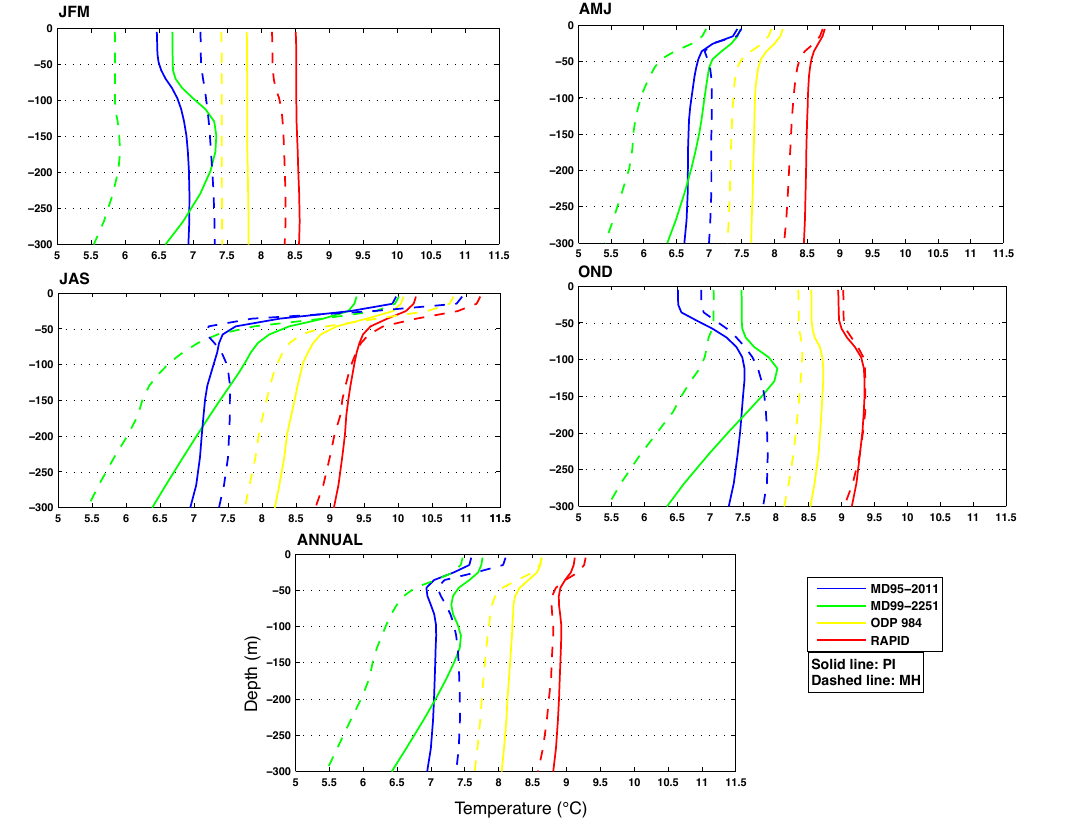
Fig. 12. Average annual and seasonal temperature profiles 0–300m depth for site MD95-2011, MD99-2251, ODP 984, and RAPiD-12-1K from the CCSM3 model